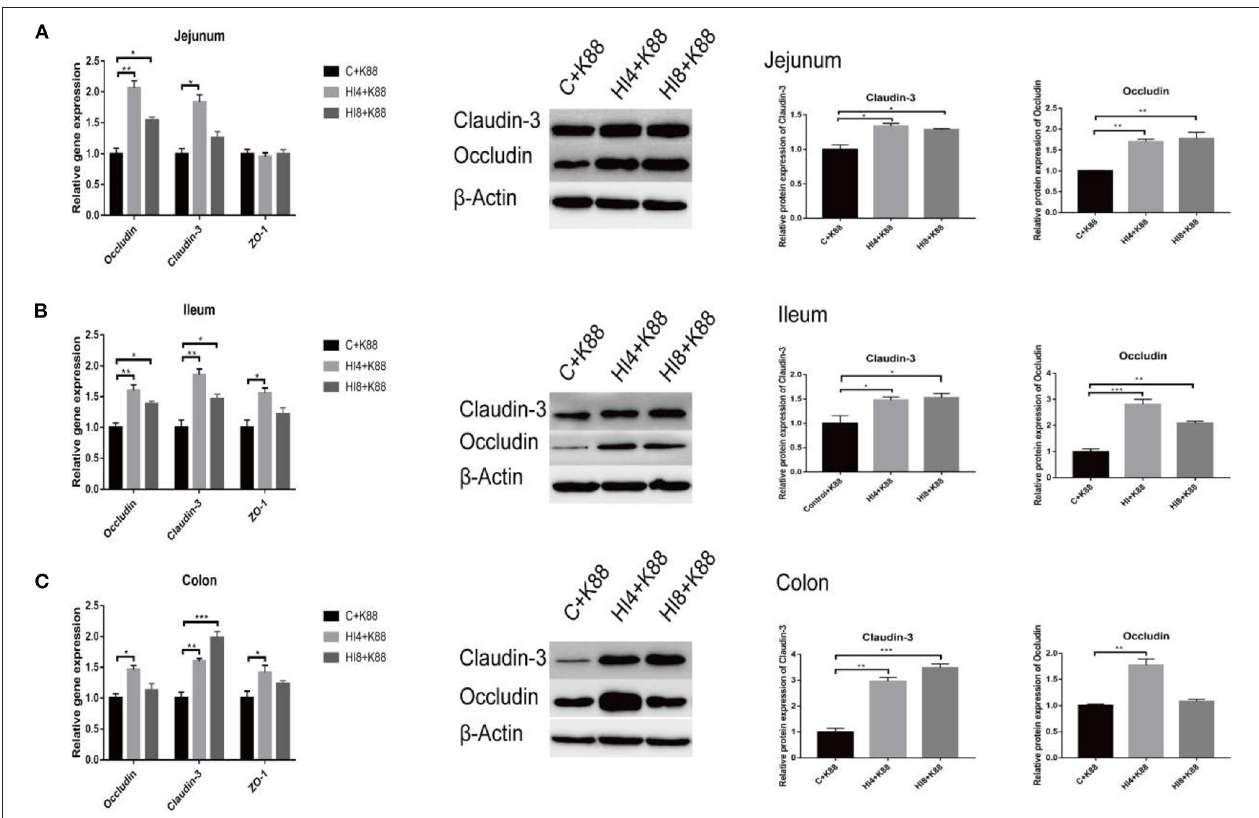
FIGURE 5 | Effects of dietary supplementation of Hermetia illucens larvae on real-time mRNA expression and protein of barrier function genes in jejunal mucosa, ileum mucosa, colon mucosa. (A) Representative immunoblots and quantification of Claudin-3 , and Occludin expression in the jejunum ( n = 3). (B) Representative immunoblots and quantification of Claudin-3 , and Occludin expression in the ileum. (C) Representative immunoblots and quantification of Claudin-3 , and Occludin expression in the colon. * P < 0.05, ** P < 0.01, *** P < 0.001, ( n = 3). Data are based on an average of three independent